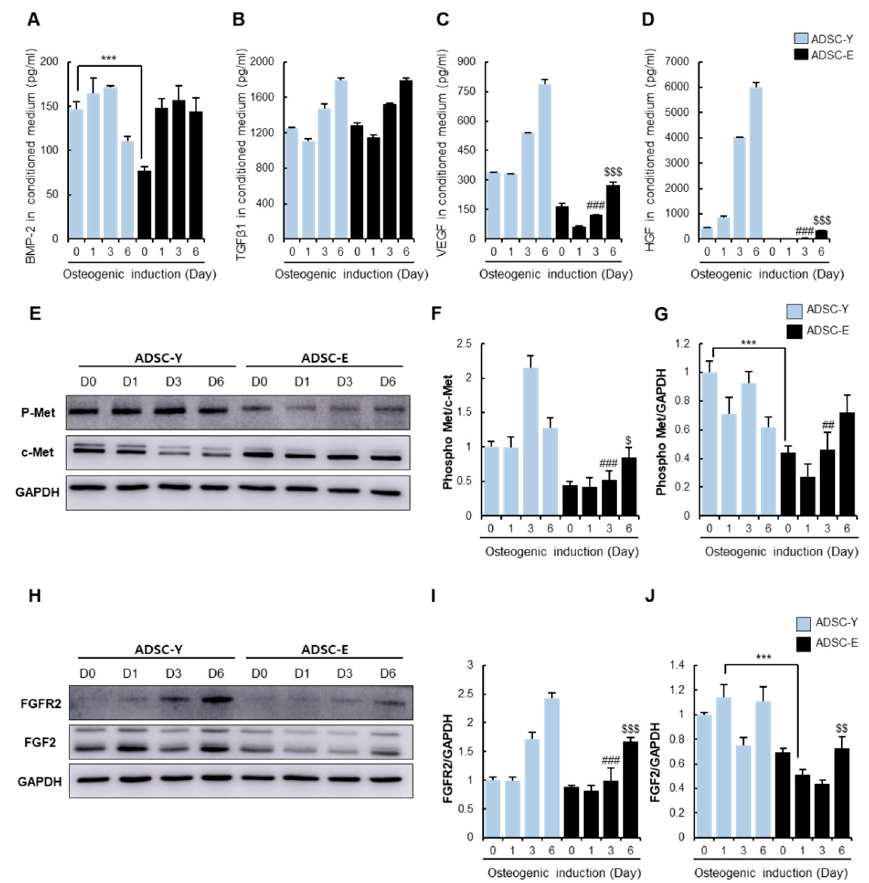
Figure 2. The analysis of the expression pattern of osteogenic factors in ADSC-Y and ADSC-E under osteogenic induction . ADSC-Y and ADSC-E were cultured in osteogenic media, respectively, and its